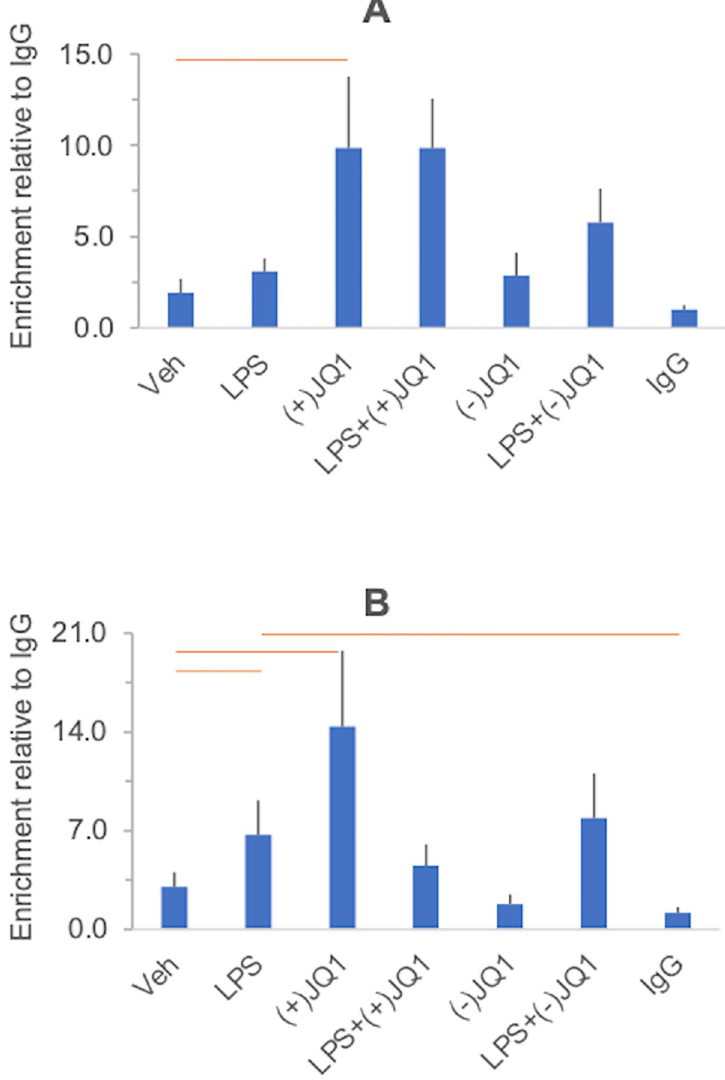
Fig 11. The effects of LPS, (+)-JQ1 and (-)-JQ1 on histone 4 acetylation at the IL10 (Panel A) and IDO1 (Panel B) promoters in DSCs. Experimental details and data presentation are the same as in Fig 10. Columns show the mean ± SEM, n = 5–6 independent experiments. Significant differences (at 5% FDR), highlighted in the heatmap in Fig 9, are indicated by the horizontal orange and blue lines. The results of the individual experiments and summary statistics are presented in the S1